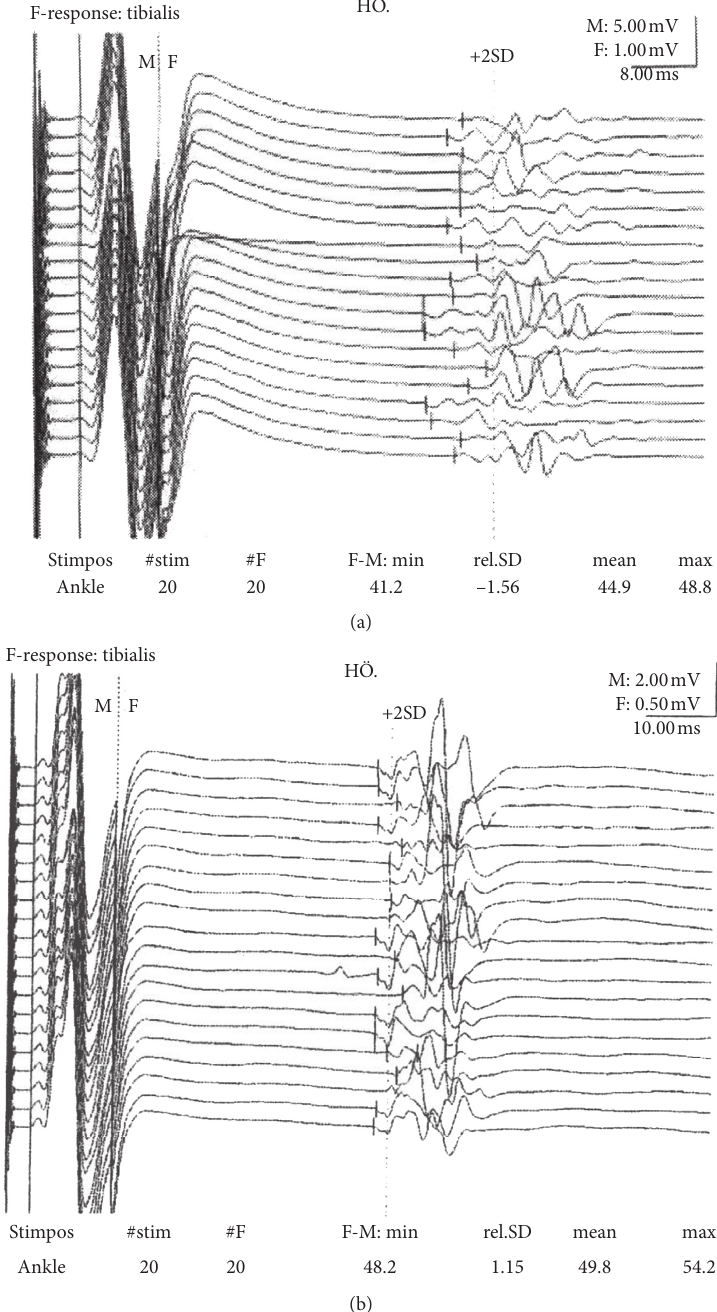
Figure 1: Nerve conduction studies in 2010 (a) indicating F-wave hyperexcitability in the tibial nerve with reduced minimal latency of 41.2ms, a polyphasic appearance, and persistence. Nerve conduction studies in 2015 (b) showing a normalized minimal latency of